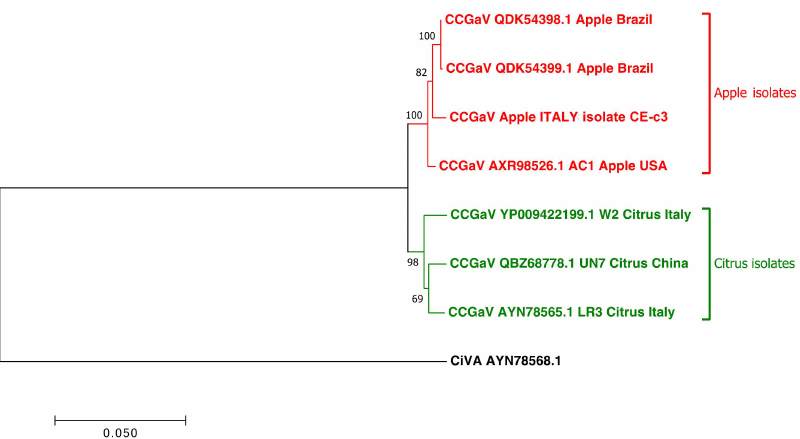
Figure 2. Phylogenetic tree generated using all the RNA1 genomic sequences of CCGaV available in databases and the Italian apple isolate CE-c3. Alignment of the nucleotide sequences with Clustal Omega was used for inferring the phylogenetic tree by the maximum likelihood method and adopting the best model JTT + I + F using MEGA7. Bootstrap probability values (1000 replicates) higher than 50% are shown at the branch nodes. Tree branches are proportional to the genetic distances, with the scale bar indicating substitutions per nucleotide site. Accession number, host, and country of origin of each CCGaV isolate are indicated at each branch tip. Citrus virus A (CiVA) was used as an outgroup.